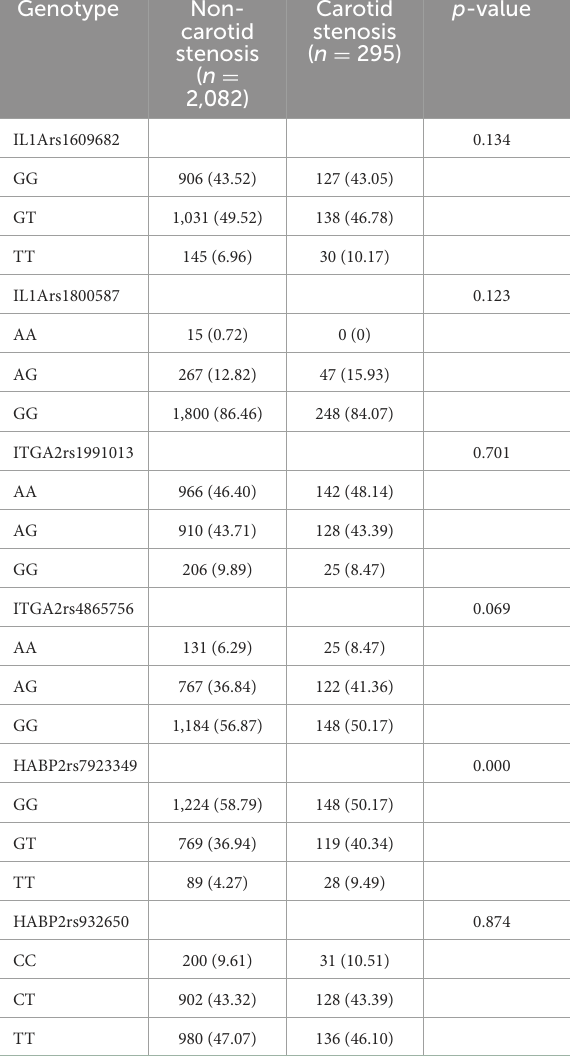
TABLE 3 Genotype distribution in moderate to severe carotid stenosis group and the group without moderate to severe carotid stenosis ( n